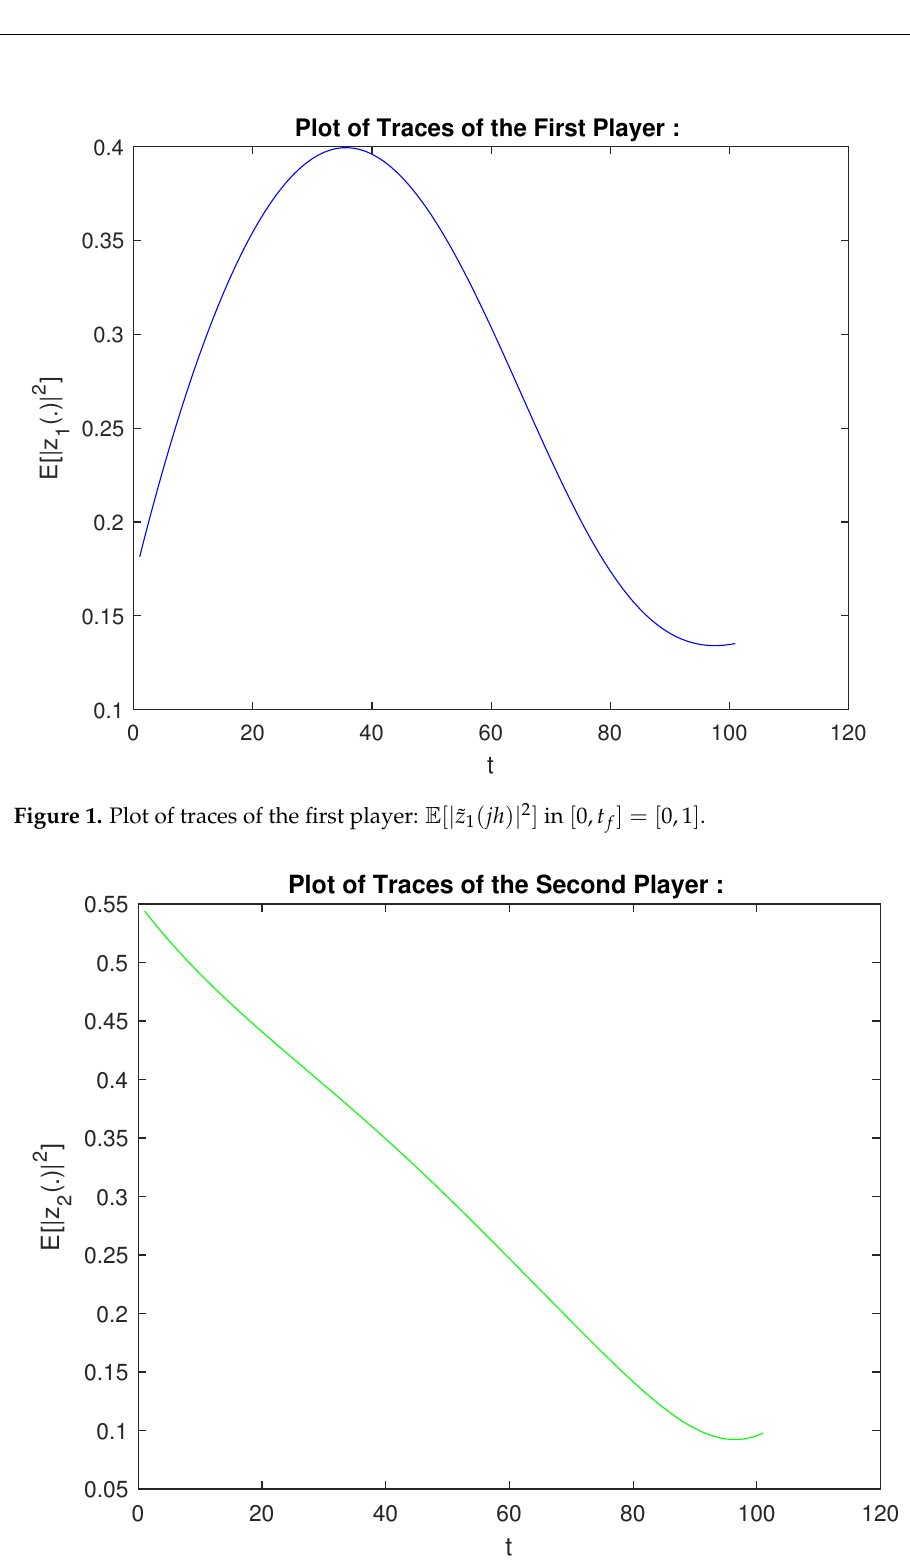
Figure 2. Plot of traces of the second player: E [ | ˜ z 2 ( jh ) | 2 ] in [ 0, t f ] = [ 0,1 ]